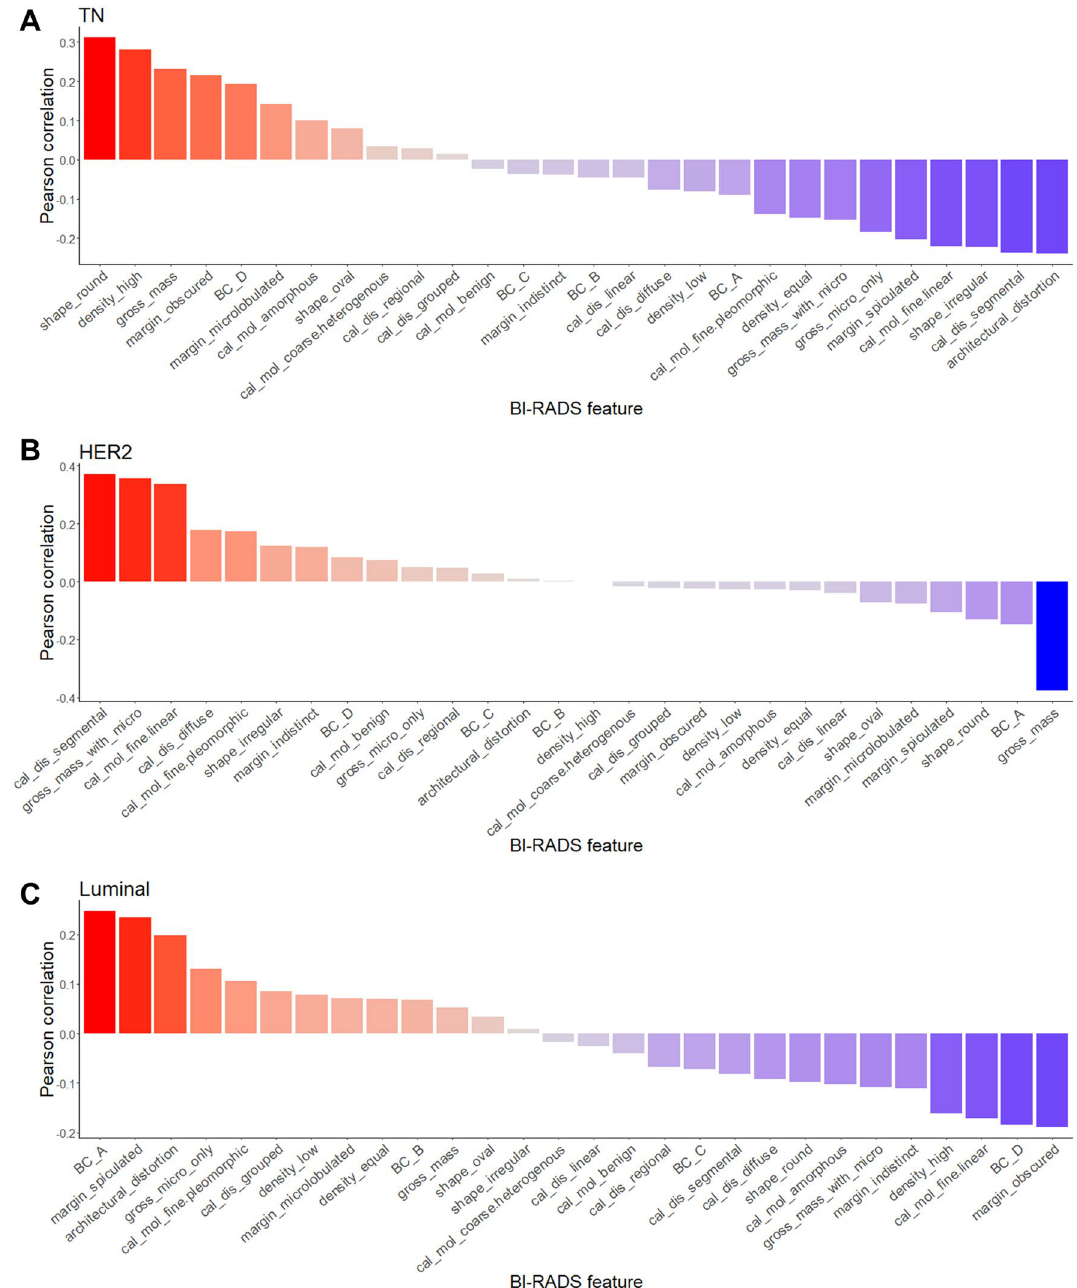
Figure 5. Correlation between the radiomics signature and BI-RADS features for the ( A) TN, ( B) HER2 and ( C) luminal